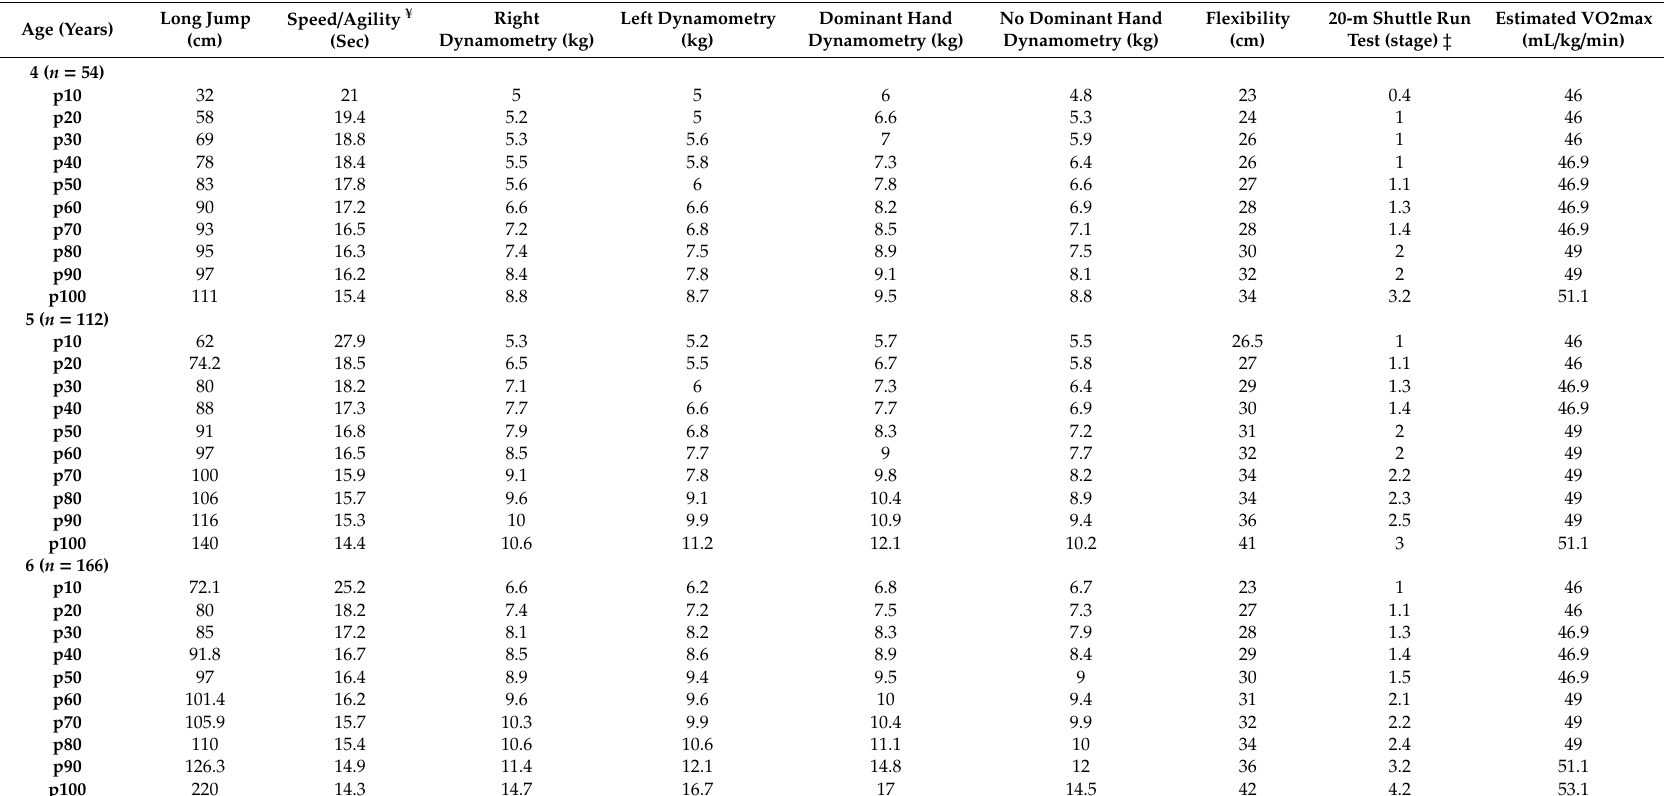
Table 7. Percentile values for boys in fitness